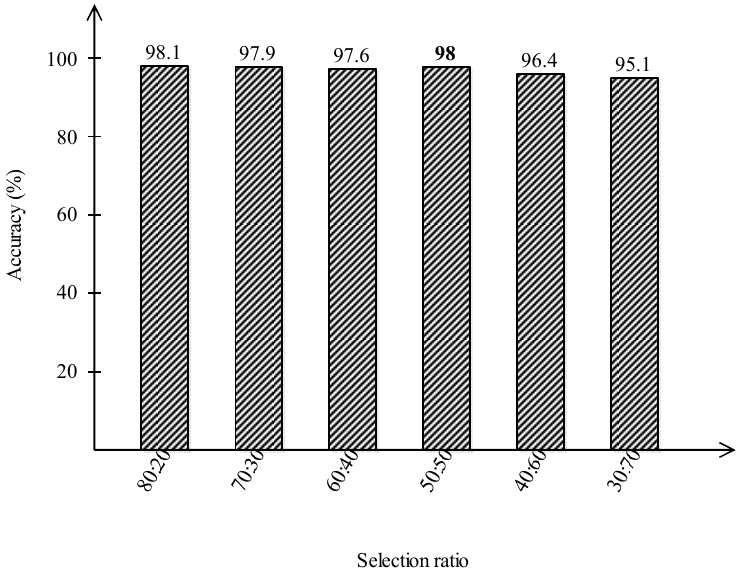
Figure 12. Classification results of MC-SVM for several training/testing ratios.